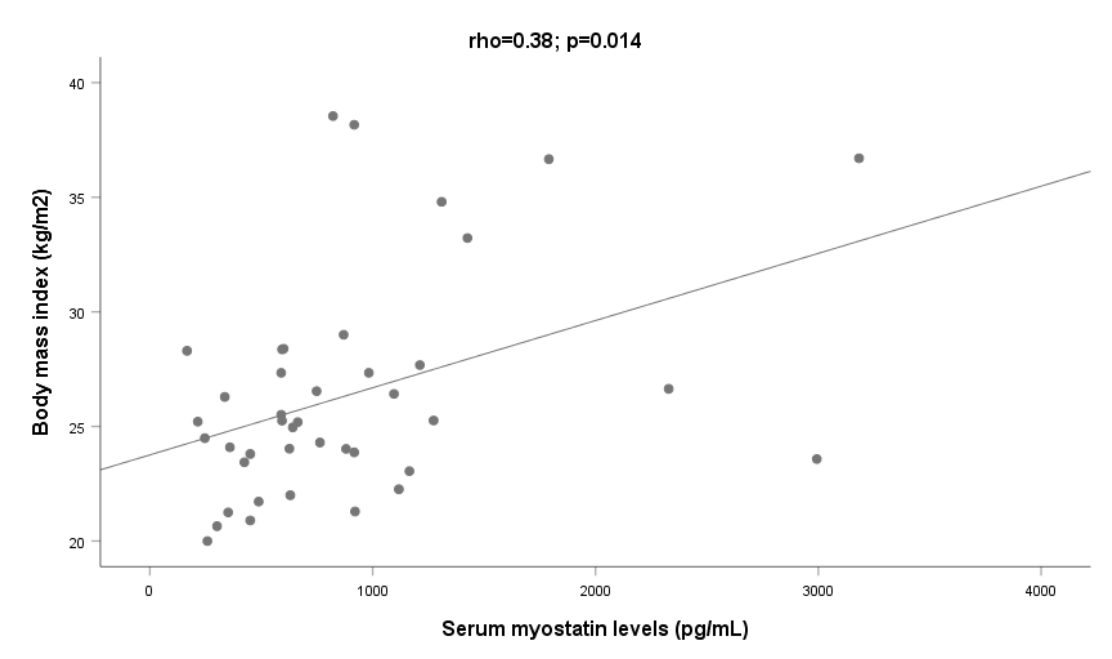
Figure 4. Relationship between serum myostatin and body mass index among patients (N = 47). Serum myostatin levels were significantly higher among patients classified as obese according to BMI (>30 kg/m 2 ; Z = 2.86; p = 0.004, Figure 5).